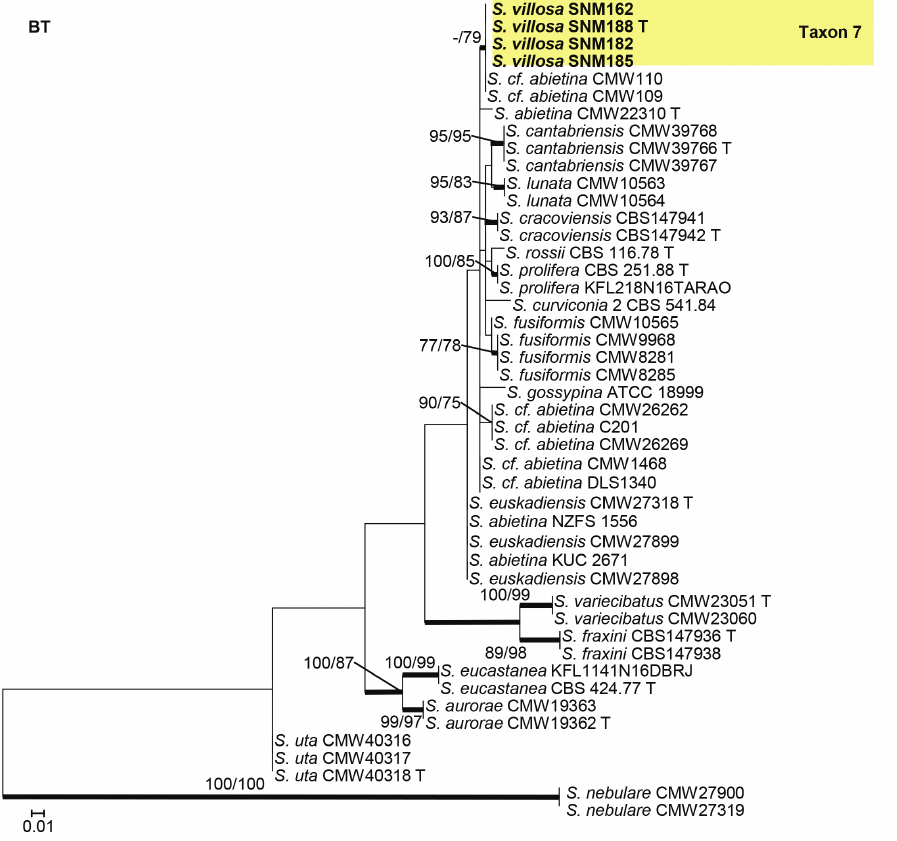
Figure 7. Maximum likelihood phylogeny of Sporothrix gossypina species complex using partial BT gene region. The isolates recovered in this study are highlighted in color and in bold font. ML and MP boot- strap support values ≥ 75 are indicated at the nodes as ML/MP. Bold branches indicate posterior prob- abilities values ≥ 0.9. T indicates ex-type